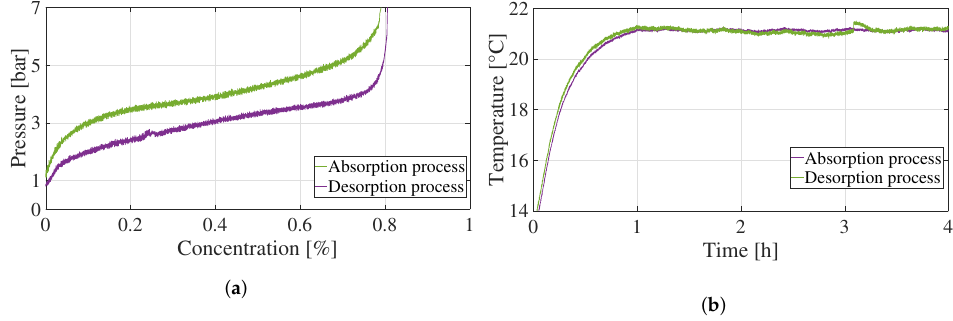
Figure 7. Degraded state of the tank: ( a ) Pressure versus concentration, ( b ) Temperature versus time. Comparing qualitatively the pressure curve as a function of concentration in Figure 7a with the curve in Figure 6a shows a loss of reversible hydrogen storage capacity, a consid- erable increase in the slope of the plateau, and a reduction in the hysteresis between